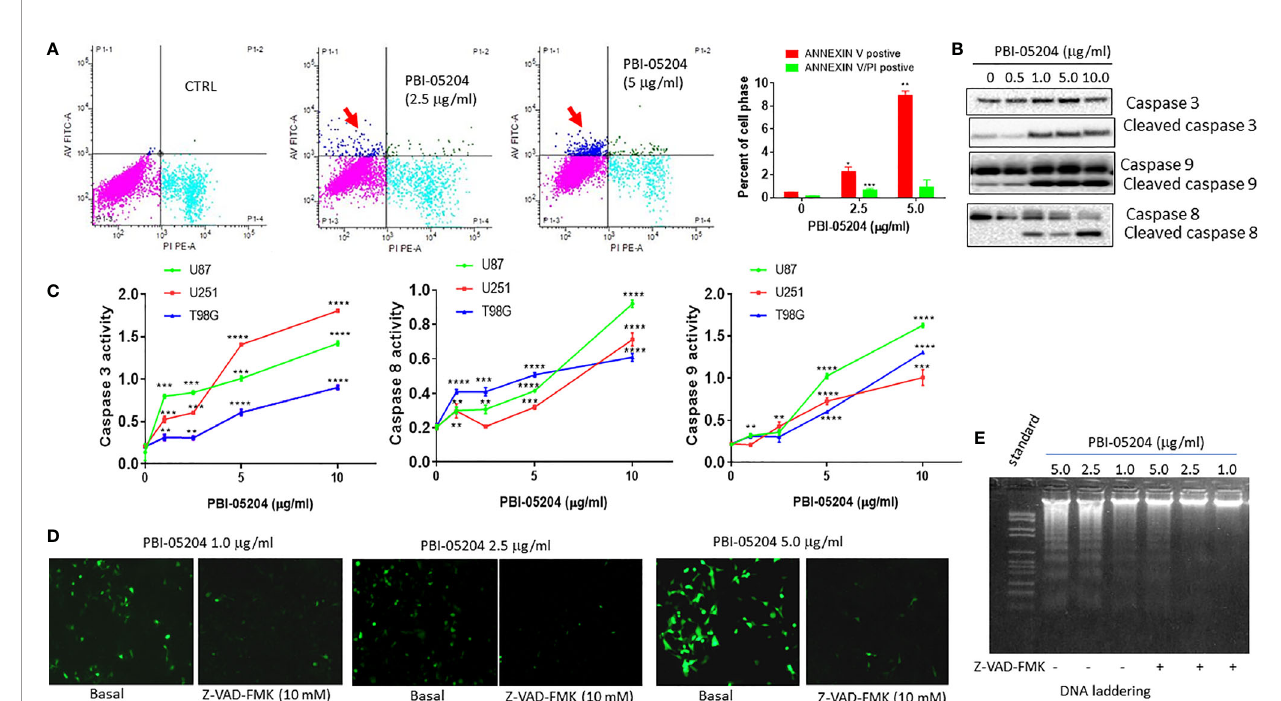
FIGURE 2 | PBI-05204 inhibited the growth of human GBM cells by induction of apoptosis. (A) Apoptotic cell death analysis of U87MG cells treated with PBI- 05204 and measured by PI and ANNEXIN-V staining. Red arrow indicates Annexin V only positive cells. (B) Expression of caspase and cleaved caspase 3, 8, and 9 in PBI-05204 – treated U251 cells. (C) Activity of caspase 3, 8, and 9 was measured by enzymatic activity assays in human U87MG, U251 and T98G cells. Experiments were performed in triplicate. (D) TUNEL staining of U251 cells treated with PBI-05204 alone or combination of Z-VAD-FMK and PBI-05204. (E) DNA ladder in U251 cells treated with PBI-05204 alone or combination of Z-VAD-FMK and PBI-05204. Data are presented as mean +/- SD. **p < 0.01, ***p < 0.001, ****p < 0.0001 versus